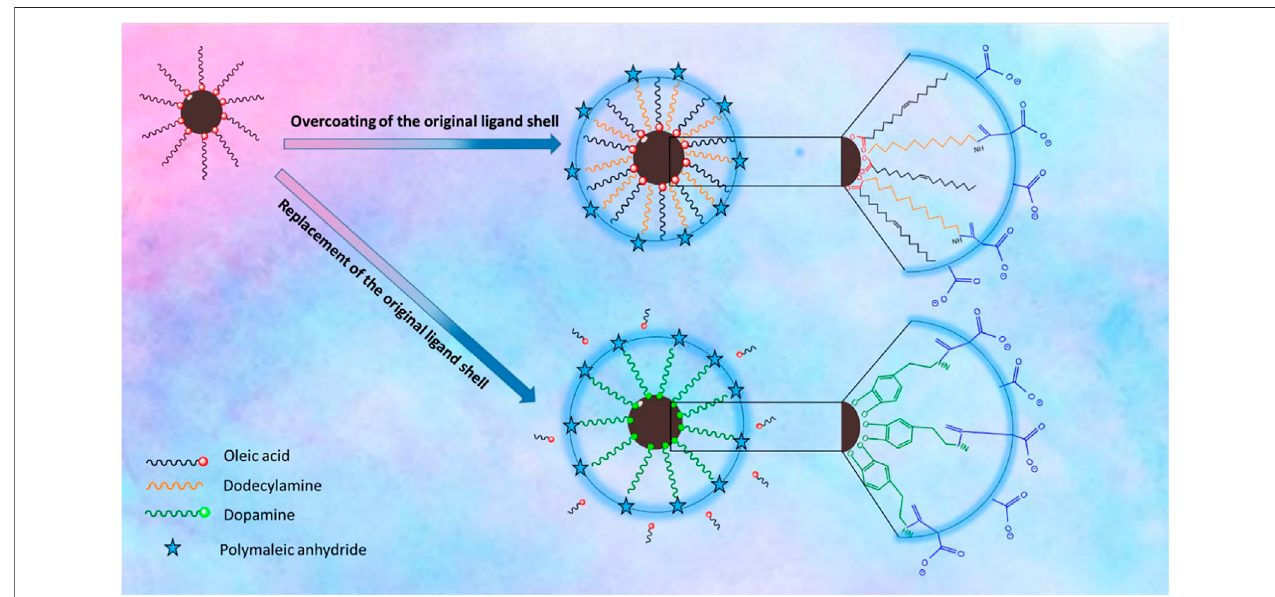
FIGURE1| Schematic illustration ofthesurface chemistry ofthe IONPs viaovercoatingofthe originalligand shell which relies on coating ofthenative hydrophobic IONPs with an amphiphilic polymer PMA – DDA; replacement of the original ligand shell involves the removal of the original ligand and replacing it with dopamine- functionalized